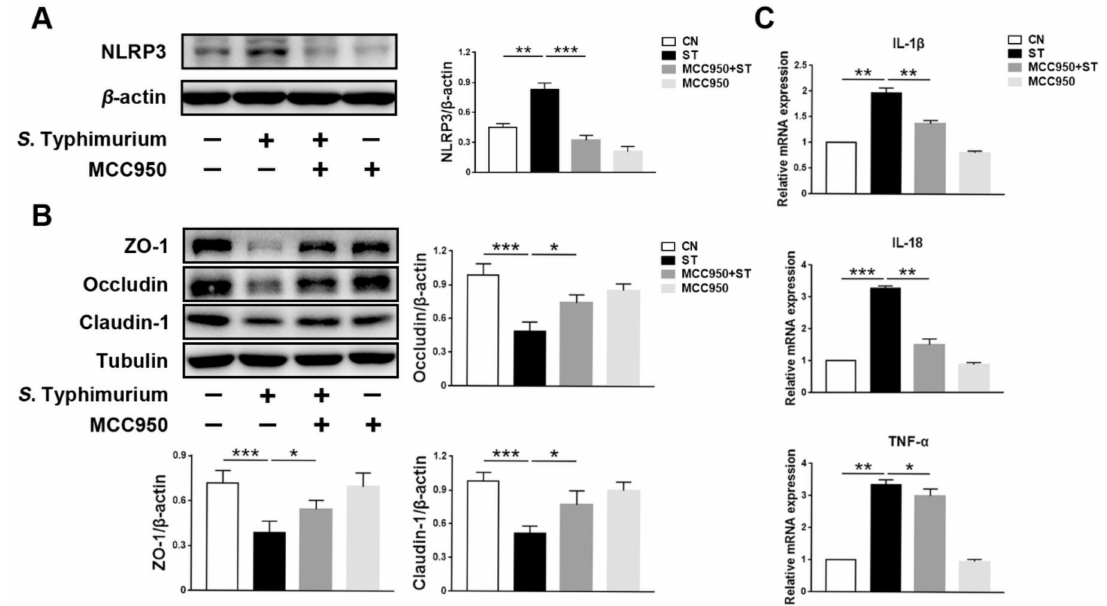
Figure 3. L. johnsonii L531 inhibits S. Typhimurium-induced assembly of the NLRP3 inflammasome to maintain tight junctions. ( A ) Western blotting of NLRP3. ( B ) Western blotting of ZO-1, Occludin, Claudin-1. ( C ) Pro-inflammatory cytokines mRNA expression levels in IPEC-J2 cells were detected by qRT-PCR. CN (Control), ST ( S. Typhimurium). The panels show proteins or cytokines quantification using ImageJ software (version 1.50). The values are shown as the mean ± SEM; n = 3. * p < 0.05, ** p < 0.01, *** p <